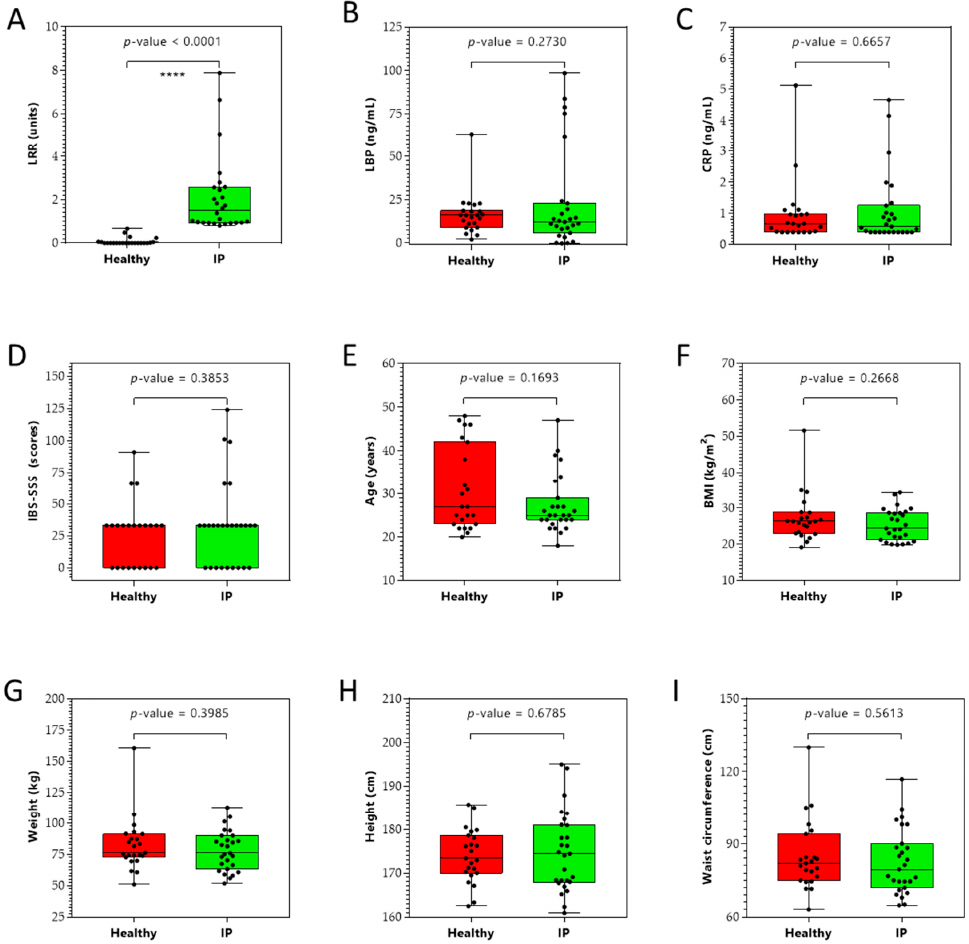
Figure 1. Clinical (panels A – D ), demographic (panel E ), and anthropometric (panels F – I ) charac- teristics of study participants ( n = 50). ( A ) Lactulose/rhamnose ratio (LRR), ( B ) lipopolysaccharide binding protein (LBP) levels, ( C ) C-reactive protein (CRP) levels, ( D ) irritable bowel syndrome se- verity scoring system (IBS-SSS), ( E ) age, ( F ) body mass index (BMI), ( G ) weight, ( H ) height, and ( I ) waist circumference of healthy and increased intestinal permeability (IP) study participants. **** p < 0.001.